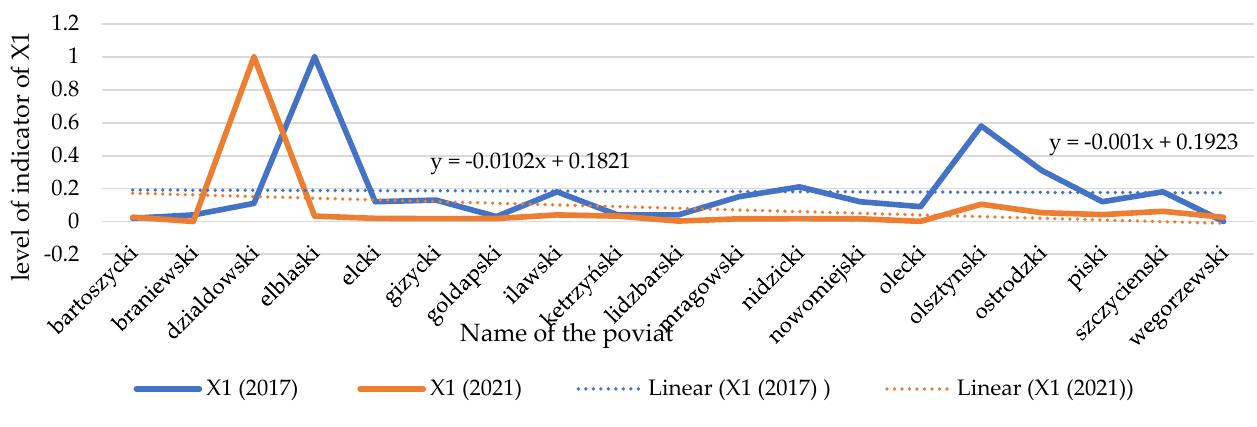
Figure 11. Temporal dynamics of the financial loss (X1). Source: own study.